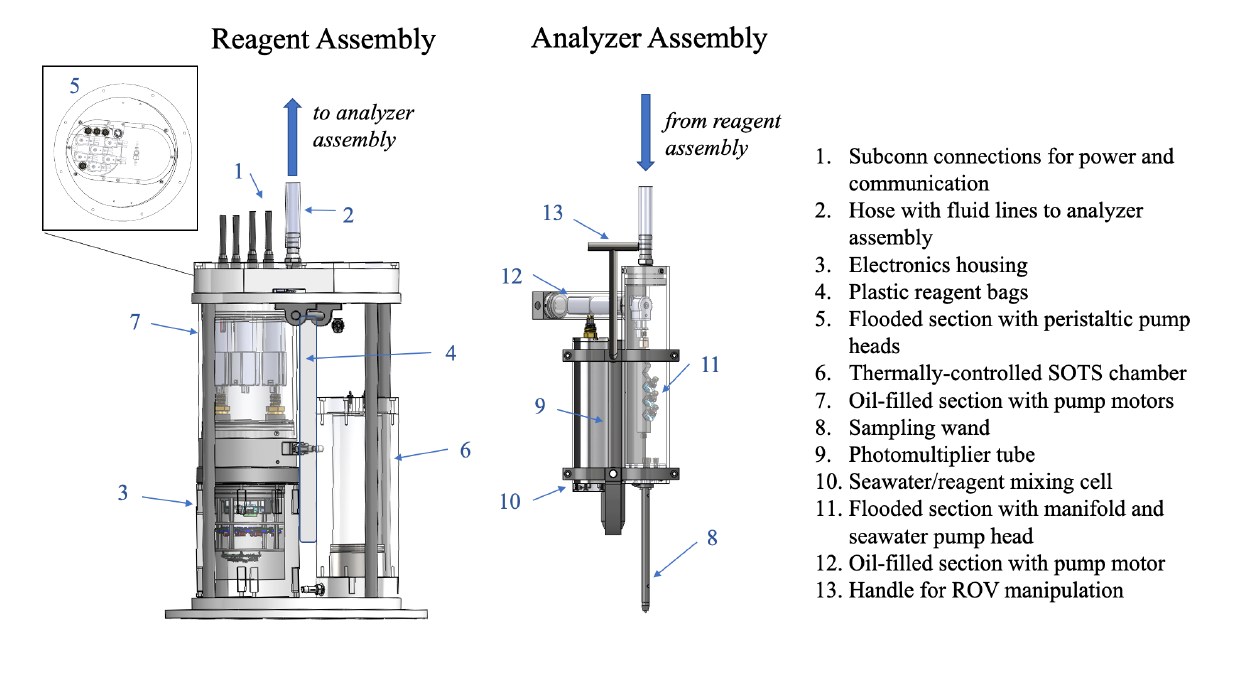
Figure 1. A schematic of the SOLARIS showing labeled parts of the reagent and analyzer assemblies.